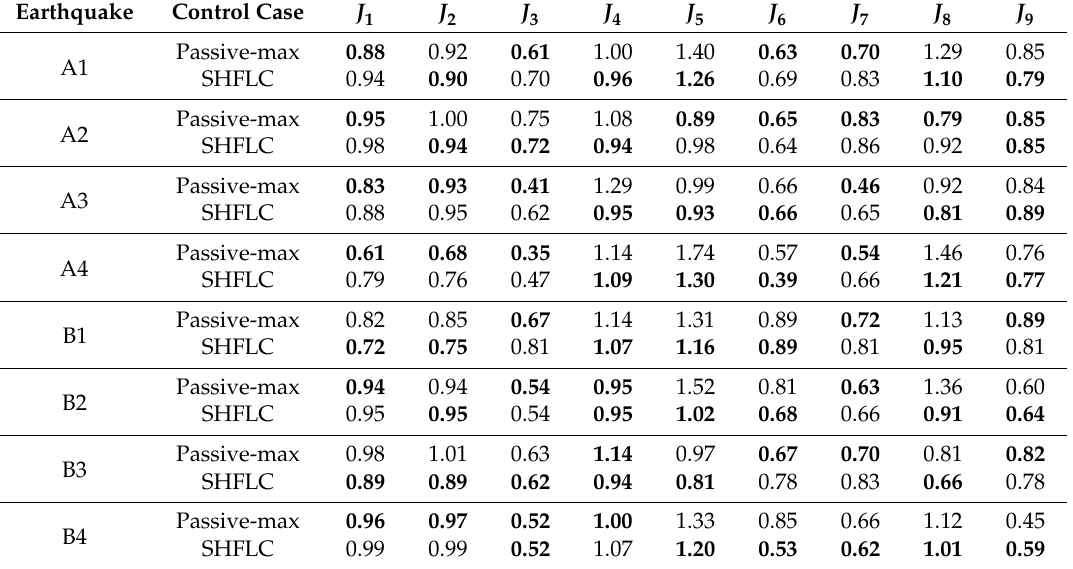
Table 7. Performance indices for various control cases under pulse-type near-fault earthquakes. Earthquake